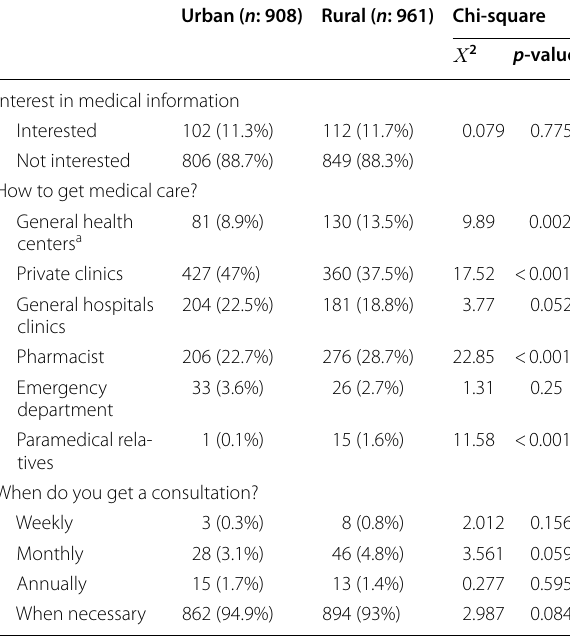
Table 2 Availability of medical care for participants Urban ( n : 908) Rural ( n : 961)